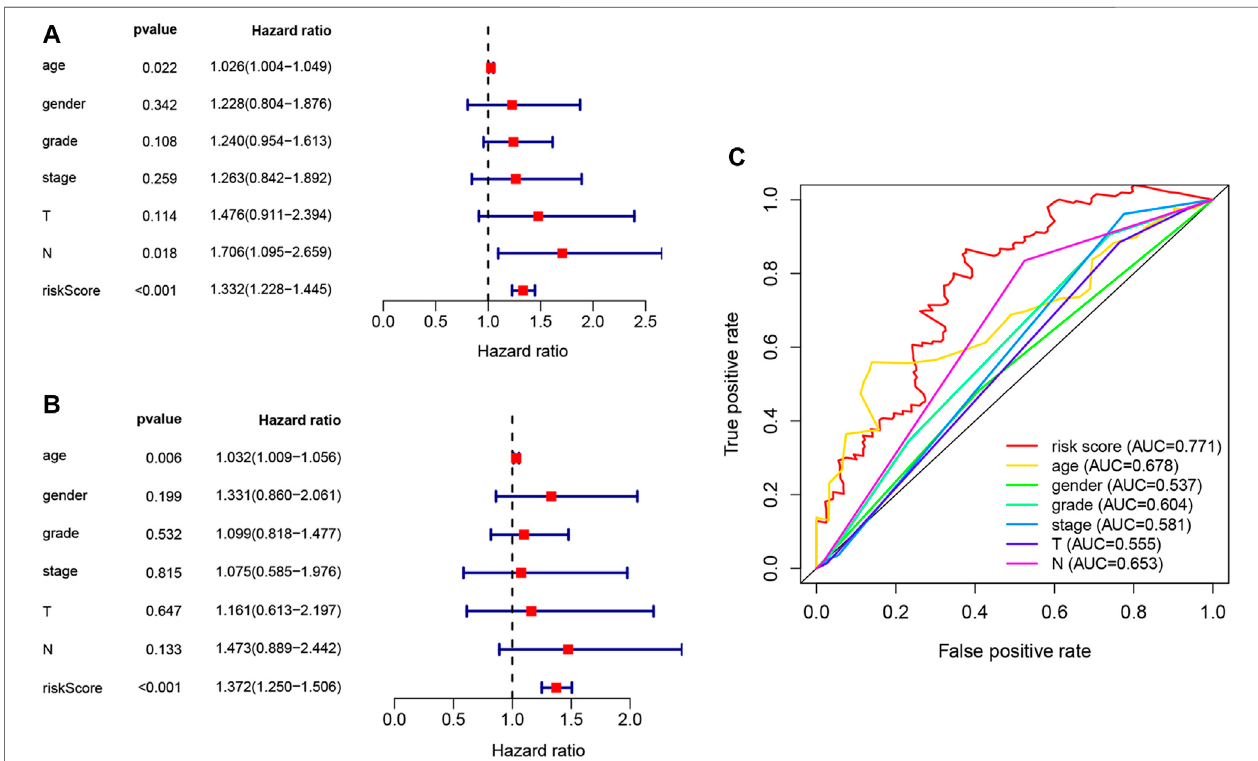
FIGURE 5 | Estimated prognostic accuracy of FRLs in patients with PAAD. (A) Univariate Cox regression showing that the age, N-stage, and risk score were associated with OS ( p < .05). (B) Multivariate Cox regression showing that the age and the risk score ( p < .01) were independent prognostic indicators of OS in patients with PAAD. (C) ROC curve showing that the risk score has the highest prognostic